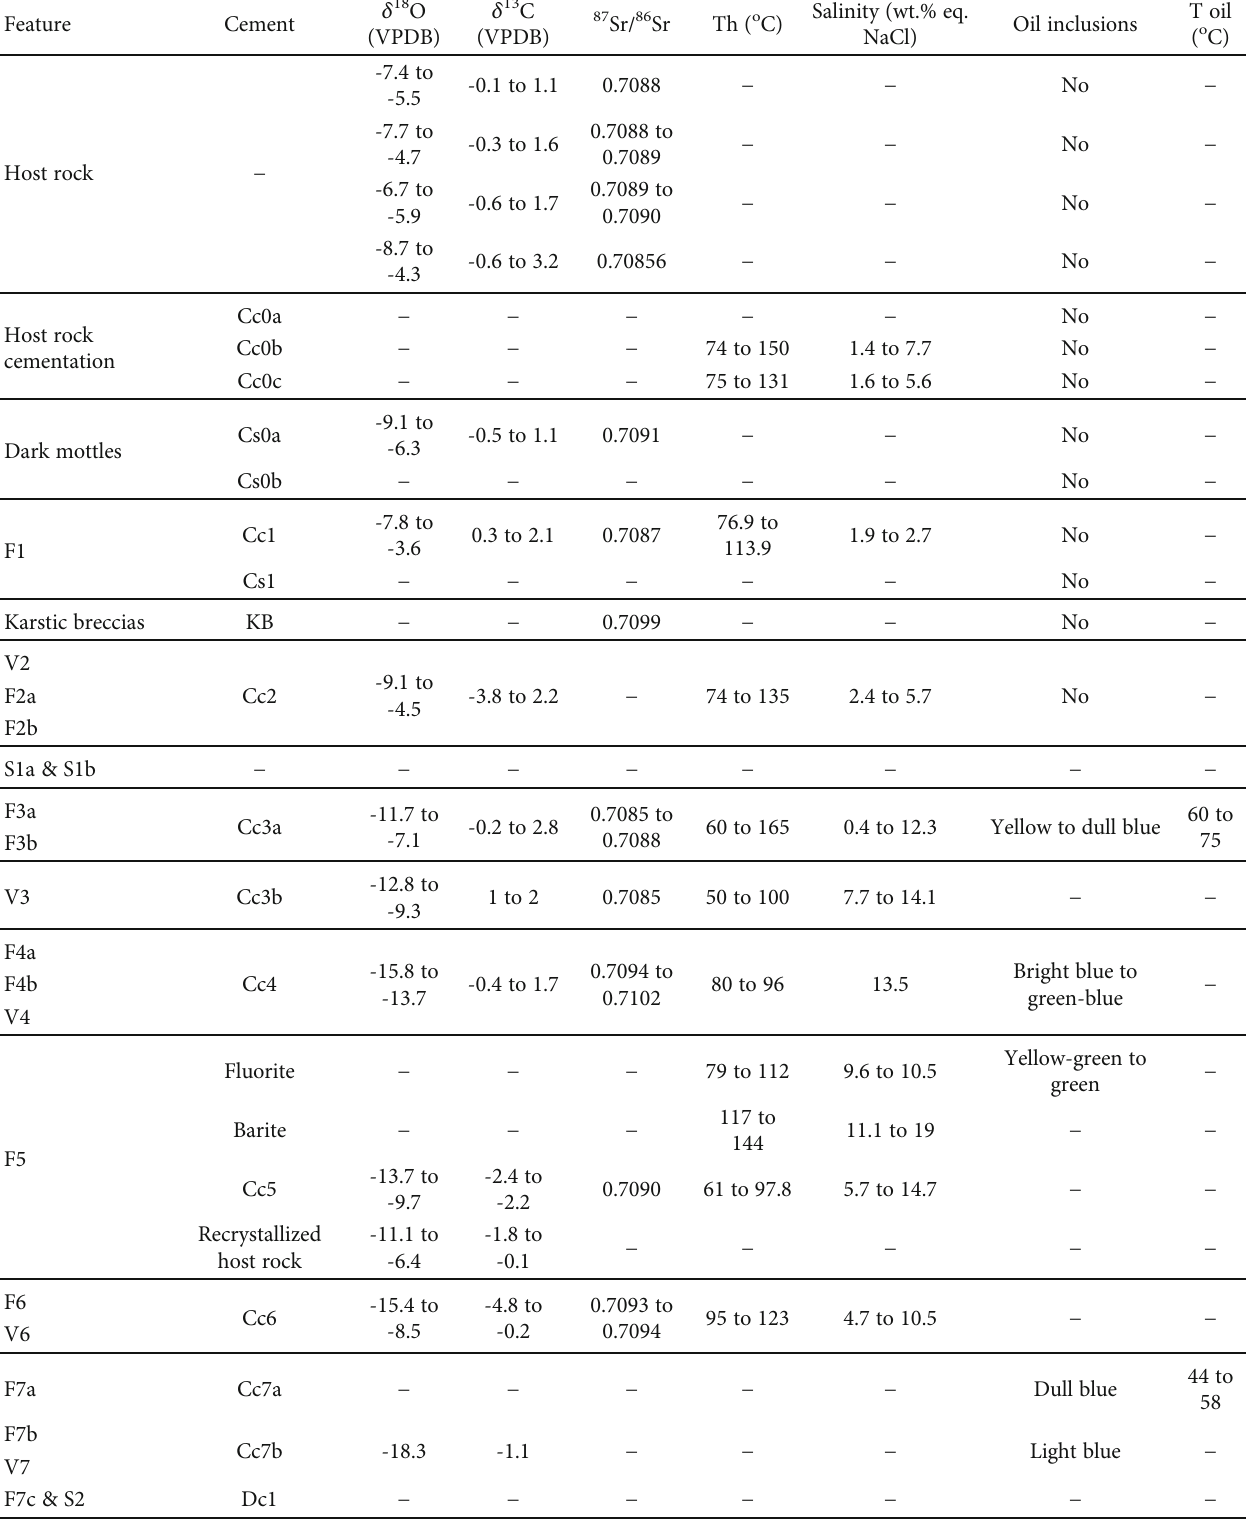
Table 2: Summary of geochemical and microthermometric characteristics of the main diagenetic features and cements shown in chronological order (paragenetic sequence). KB: matrix karstic breccia; F: fracture; V: dissolution vug; S: stylolite; Cc: calcite cement; Cs: calcite sediment; Dc: dolomite